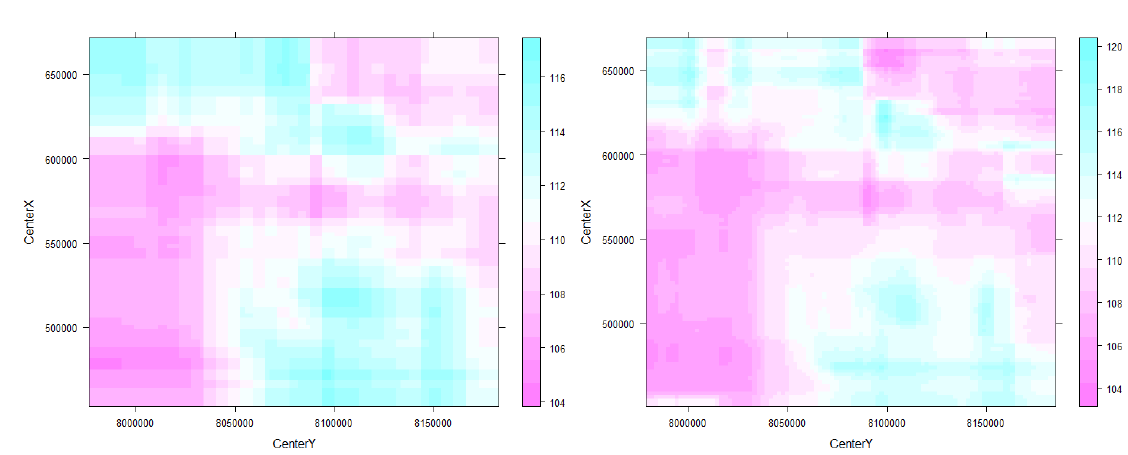
Figure 13. Prediction raster maps for the year 1990. ( a ) 12,000 m, ( b ) 6000 m ( c ) 3000 m and ( d ) 1500